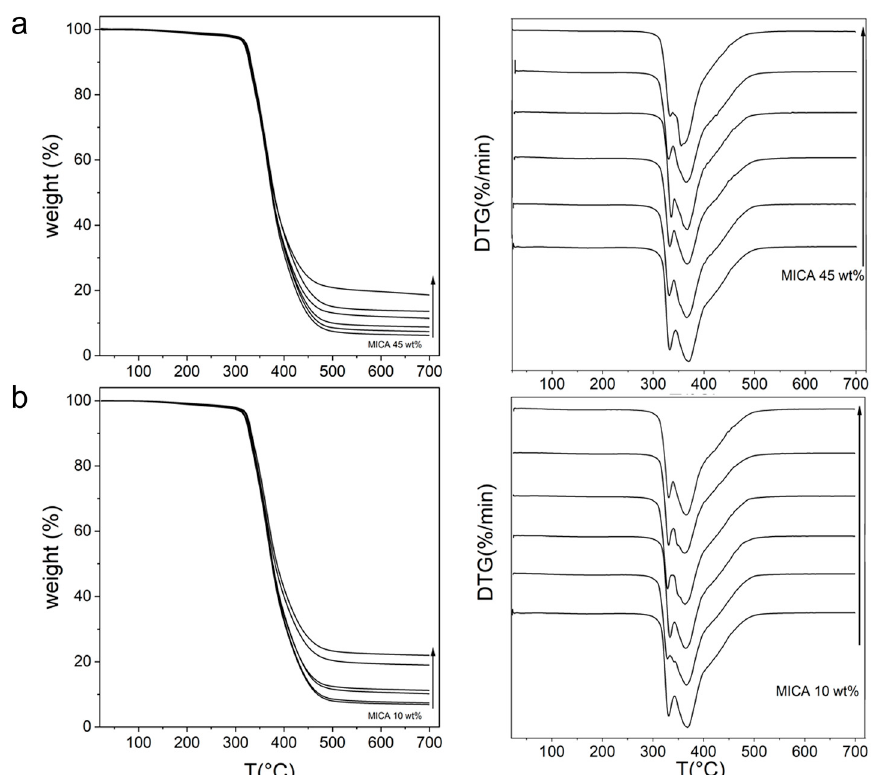
Figure 7. TGA ( left ) and DTG ( right ) curves for epoxy–mica (spanning from 0% wt to 15% wt) nanocomposites from RT to 700 ◦ C under N 2 atmosphere: ( a ) Mica 45 nanocomposites; ( b ) Mica 10 nanocomposites. Table 2. Parameters from thermal analysis of pristine epoxy and mica-composites in N 2 .